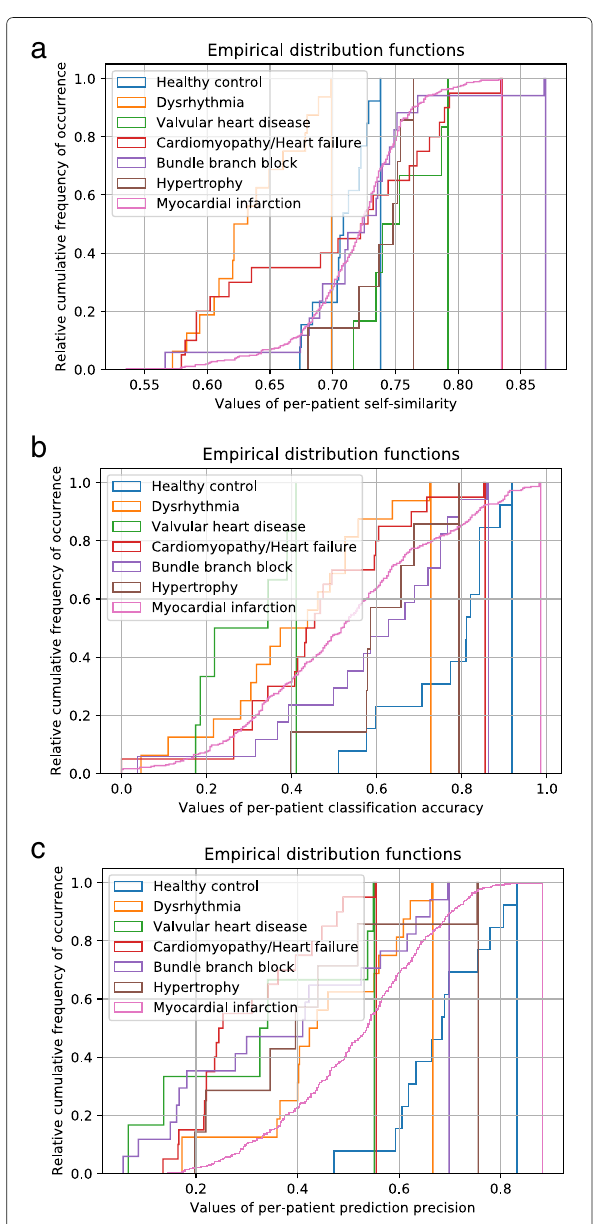
Fig. 14 Distribution of per-patient values for different comparison algorithms. a Distribution of per-patient self-similarity evaluated on test patients from different categories. b Distribution of per-patient distance-based classification accuracy evaluated on test patients from different categories. c Distribution of per-patient forecasting precision evaluated on test patients from different categories